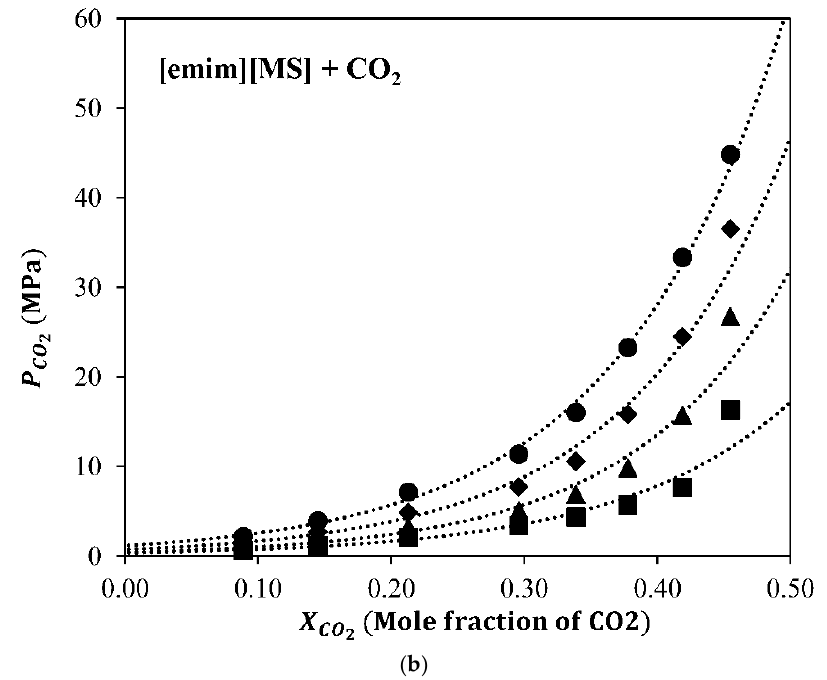
Figure 4. P−X diagram of CO 2 solubilities of the ionic liquid + CO 2 system ( a [emim][Ac], b Figure 4. P − X diagram of CO 2 solubilities of the ionic liquid + CO 2 system (( a ) [emim][Ac], [emim][MS]). The symbols represent the temperatures, respectively; (●) 303.15 K, ( ⧫ ) 323.15 K, ( ▲ ) ( b ) [emim][MS]). The symbols represent the temperatures, respectively; ( • ) 303.15 K, ( (cid:7) ) 323.15 343.15 K, and ( ■ ) 363.15 K. Adapted with permission from Yim et al. [28]. Copyright (2018) American K, ( (cid:78) ) 343.15 K, and ( (cid:4) ) 363.15 K. Adapted with permission from Yim et al. [28]. Copyright (2018) Chemical Society. American Chemical